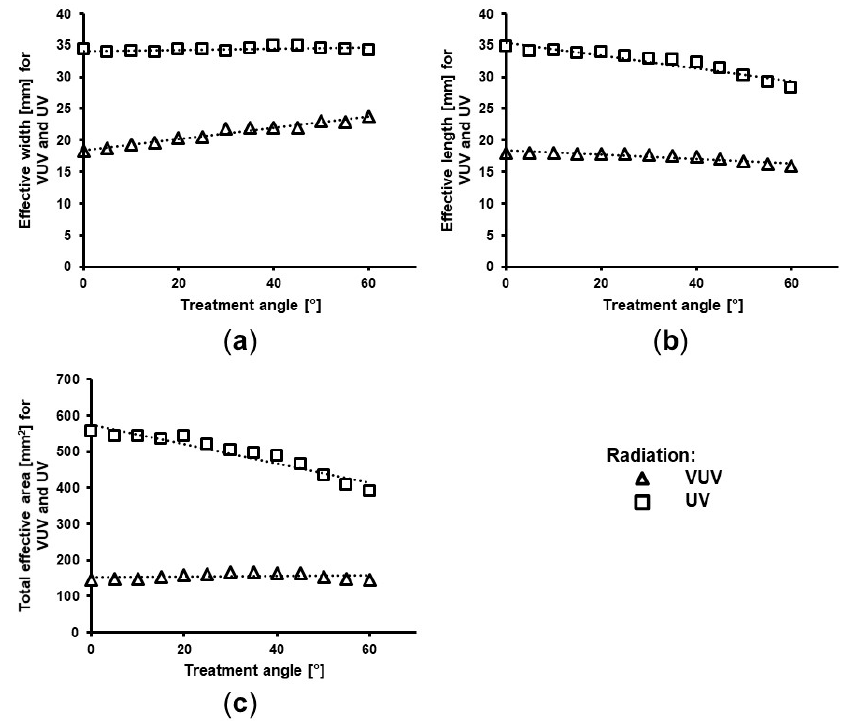
Figure 11. Alteration of ( a ) width, ( b ) length and ( c ) total area of VUV and UV irradiation caused by kINPen ® MED- β after perpendicular (0°) and tilted (5–60°) application visualized by fluorescence dyes.